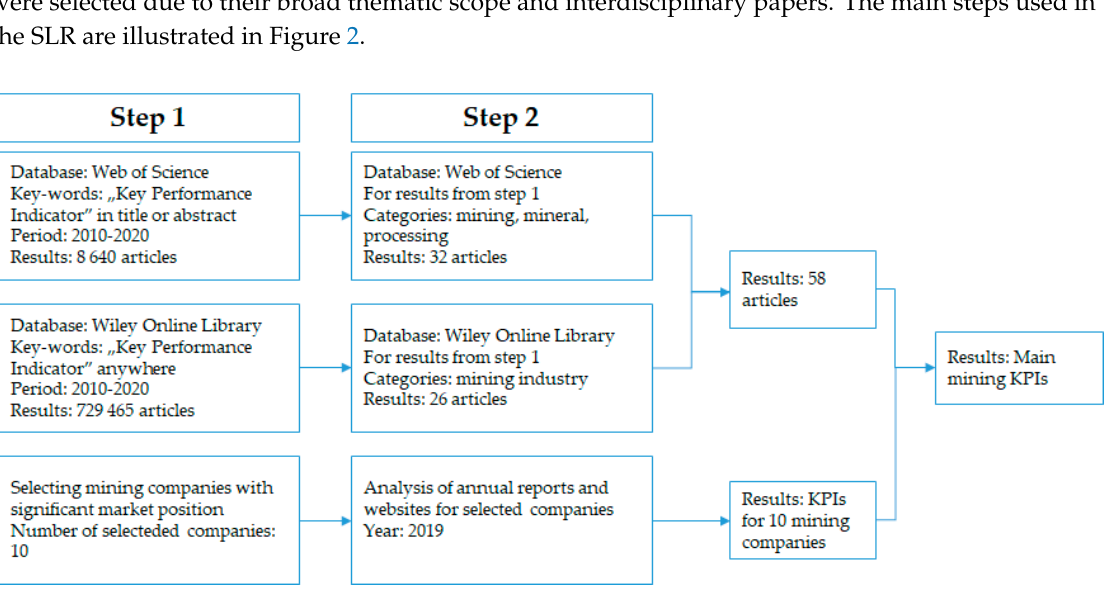
Figure 2. Selection of papers for Systematic Literature Review.